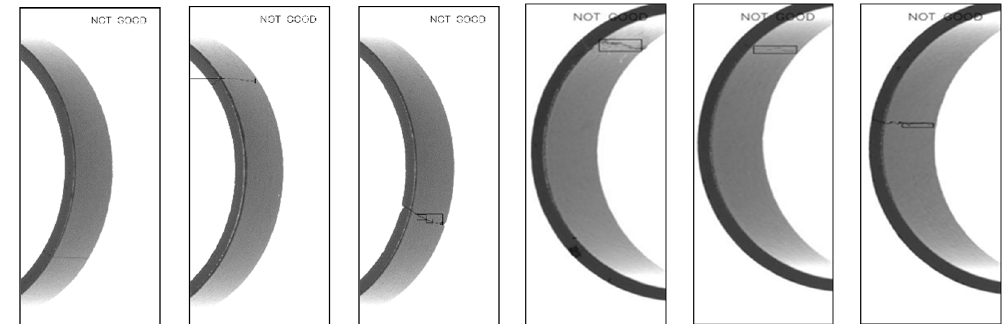
Figure 15. Detection results of crack defects.